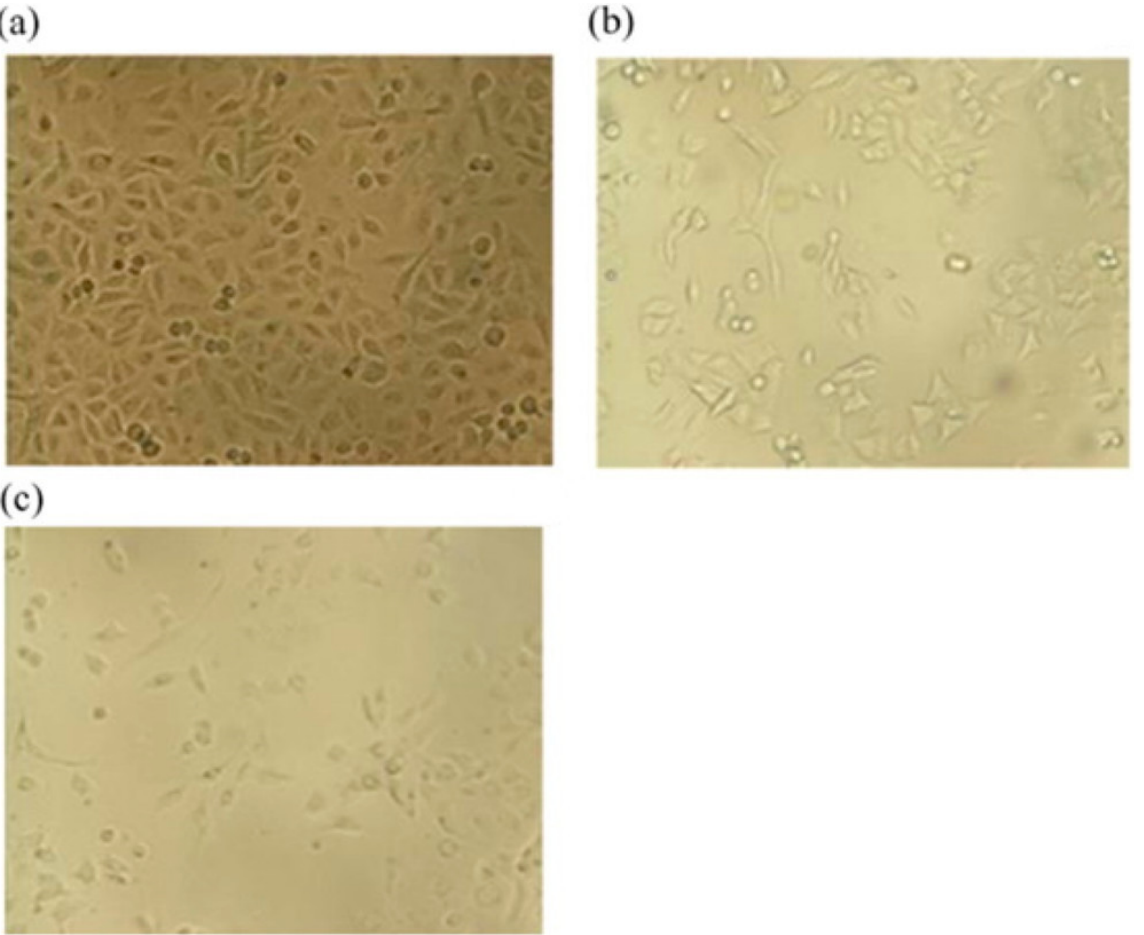
Figure 13. ( a ) Human lung cancer cells (A549), exposed to ( b ) pure DOX and ( c ) DOX-loaded PEO/CS/GO composite [237]. Reproduced with permission from ref [237]. Copyright 2015